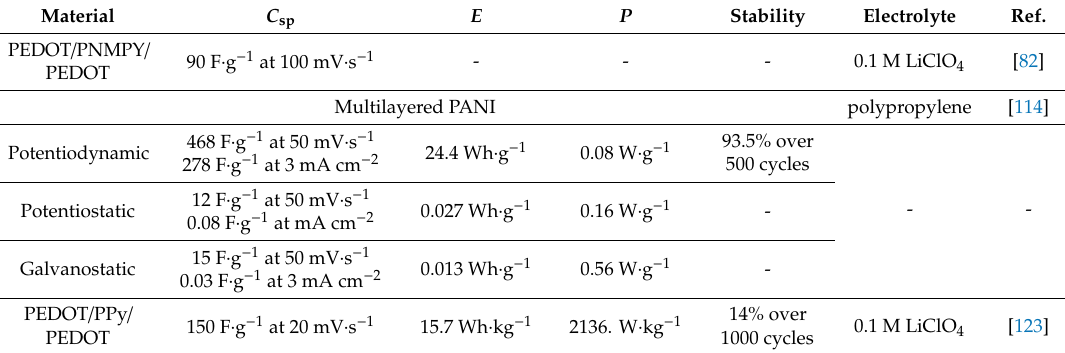
Table 1. Conducting polymer-conducting polymer-based layer-by-layer